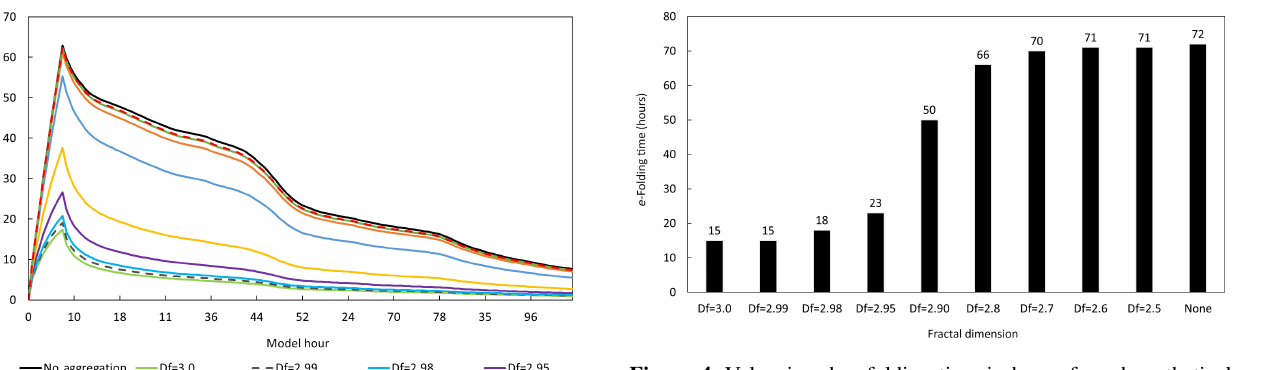
Figure 4. Volcanic ash e -folding time in hours for a hypothetical eruption on 5 May, beginning at 00:00Z and ending at 09:00Z, for a range of fractal dimensions, D f = { 3.0, 2.99, 2.98, 2.95, 2.9, 2.8, 2.7, 2.6, 2.5 } . Constant eruption rate = 4 × 10 6 kgs − 1